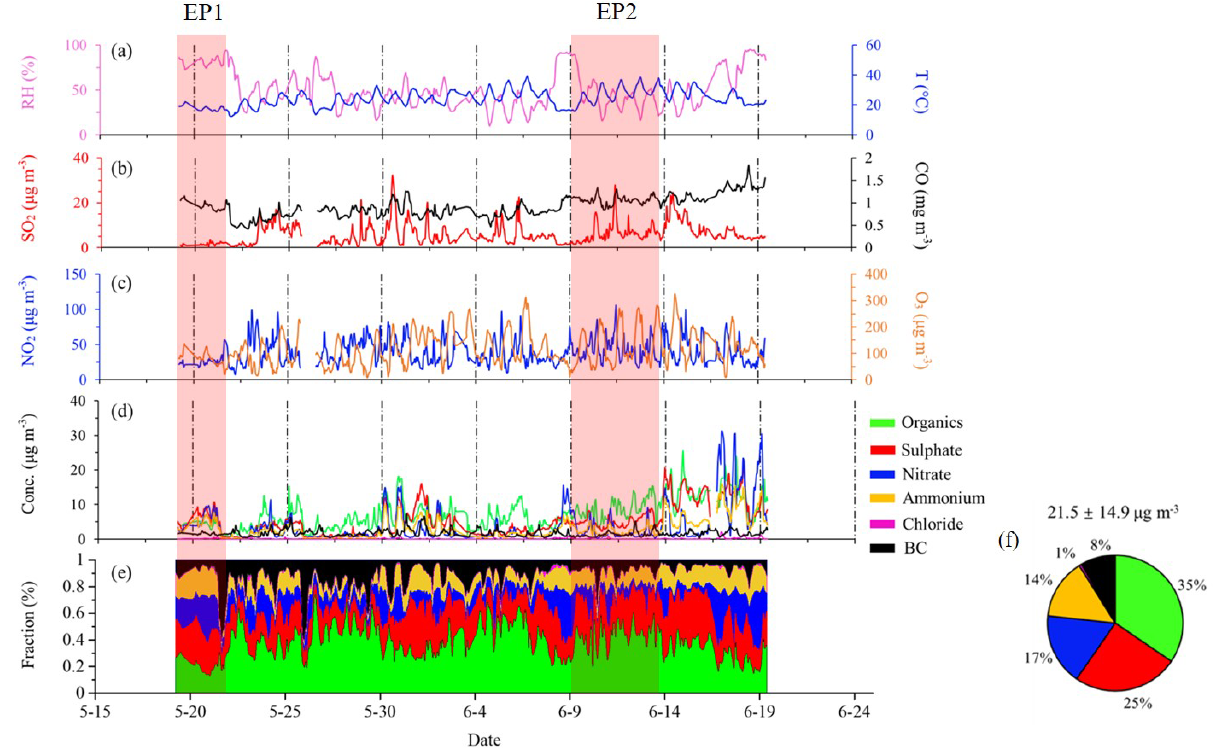
Figure 1. Time series of (a) relative humidity and temperature; (b, c) mass concentration of SO 2 , CO, NO 2 and O 3 ; and (d, e) mass concentrations and fractional contributions of PM 2 . 5 (organics, sulfate, nitrate, ammonium, chloride and BC) during the campaign period. Five pollution episodes are observed during the entire campaign, and they are analyzed in detail by the HYSPLIT model and shown in Fig. S3. EP1 and EP2 (shaded) are the only two pollution episodes caused by continuous transport from BTH and urban GZB, respectively. Therefore, they are selected for further